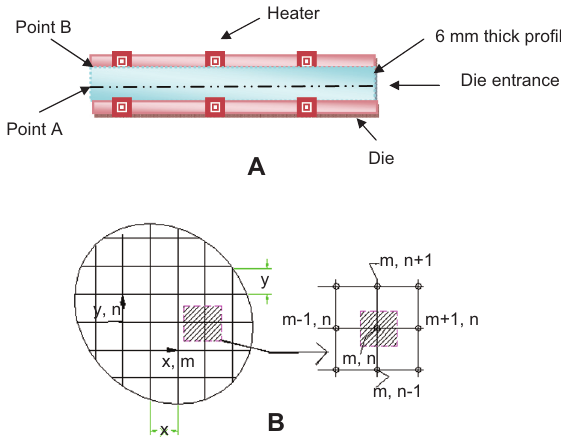
Figure 1 (A) Die with heaters and profile and (B) schematic nodal